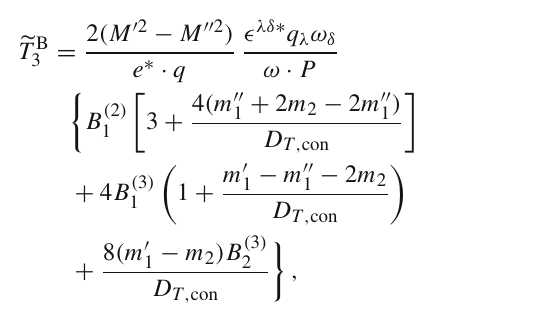
numerical results of [ T 3 ] full for B c → D ∗ at q 2 ⊥ = ( 0 , 1 , 4 , 9 ) GeV 2 with λ (cid:4)(cid:4) = ( 0 , ± 1 , ± 2 ) in Table 1, in which the SLF, valence and CLF results